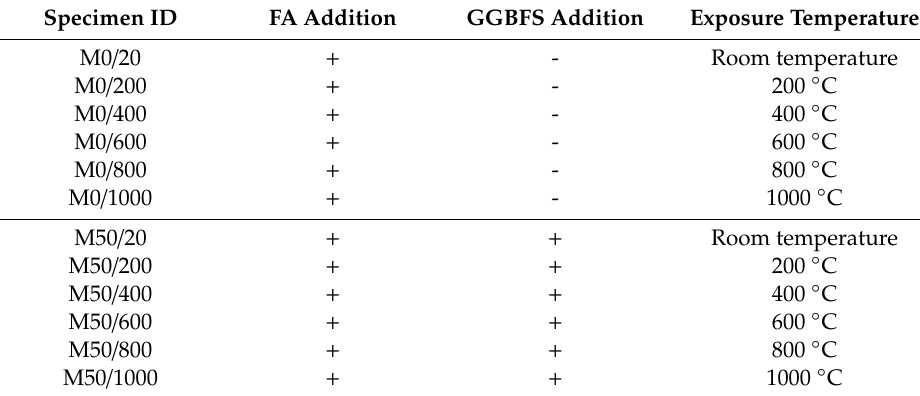
Table 4. Designation of geopolymer samples.